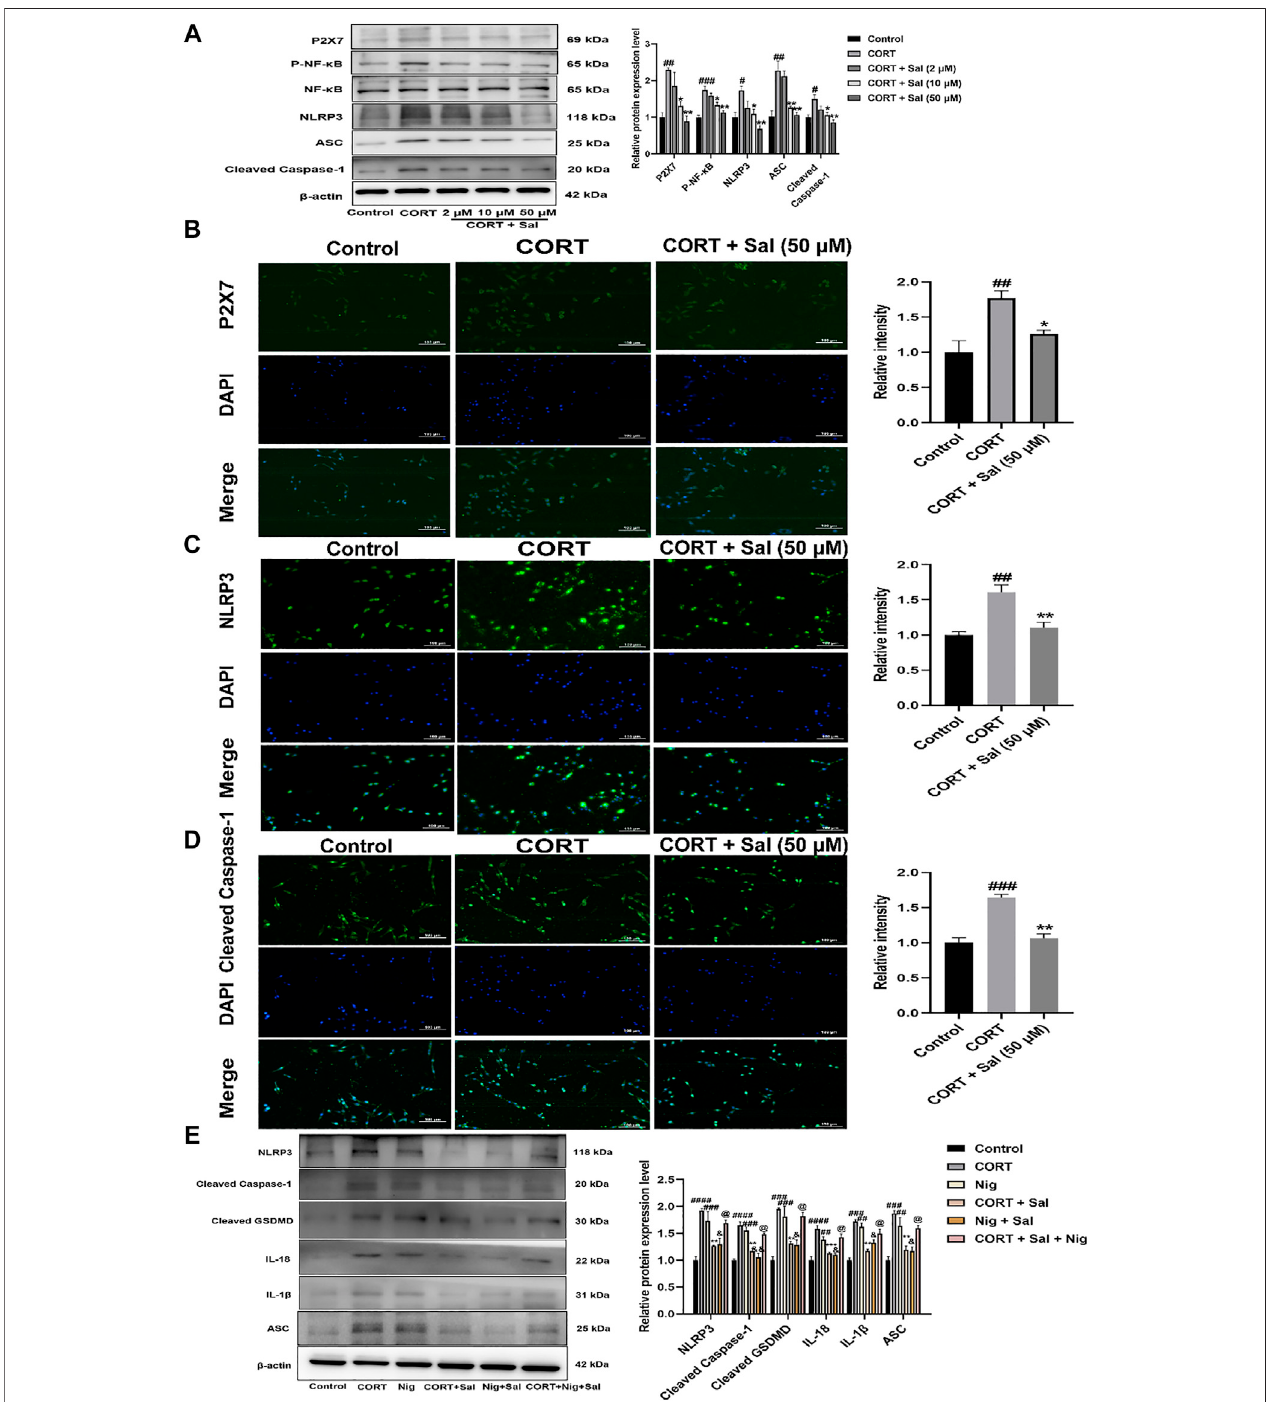
FIGURE 8 | Sal ameliorates pyroptosis by inhibiting P2X7/NF- κ B/NLRP3 signaling pathway in CORT-induced PC12 cells. (A) The protein expression of P2X7, P-NF- κ B, NLRP3, ASC, Cleaved caspase-1 in PC12 cells was detected by Western blot ( n = 3). PC12 cells were pre-treated with Sal (2, 10, 50 μ M) for 2 h, and then stimulationwith200 μ M CORT for24 h. (B) Immuno fl uorescence stainingofP2X7 inPC12 cells ( n =3). (C) Immuno fl uorescence detection oftheexpression ofCleaved caspase-1 in PC12 cells ( n = 3). (D) The results of immuno fl uorescence demonstrated the expression level of NLRP3 in PC12 cells ( n = 3). PC12 cells were pre- treatedwithSal(50 μ M)for2 h, and thenstimulation with200 μ MCORTfor 24 h.Originalmagni fi cation: ×200. (E) Theprotein levelsofNLRP3,ASC,Cleaved caspase- 1,IL-1 β ,IL-18,andCleavedGSDMDweredetectedusingWesternblot( n =3). #### p < 0.0001, ### p < 0.001, ## p < 0.01versusthecontrolgroup;*** p < 0.001,** p < 0.01 versustheCORTmodelgroup; && p < 0.01, & p < 0.05represent Nig+Sal groupversusNiggroup; @ p < 0.05representCORT+Sal +Nig groupcompared withCORT + Sal